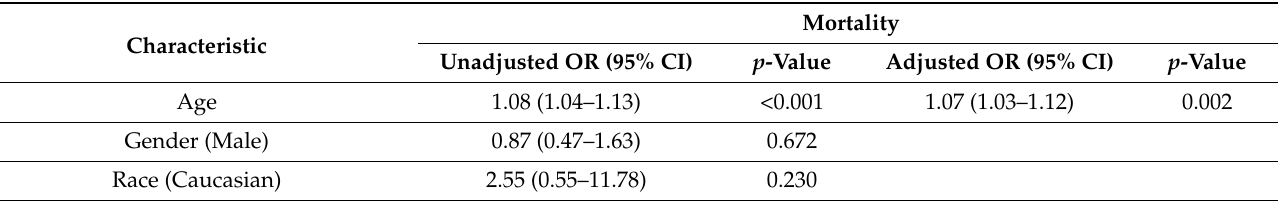
Table 3. Univariate and multivariate analyses of factors predictive of early